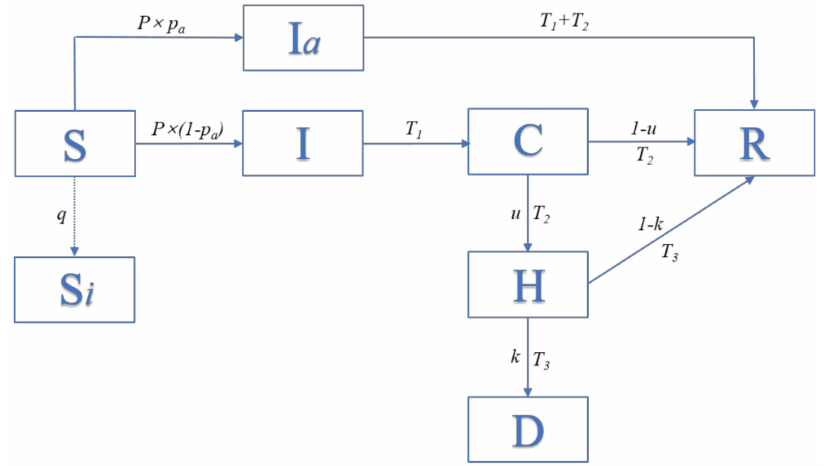
Figure 1. The state transition